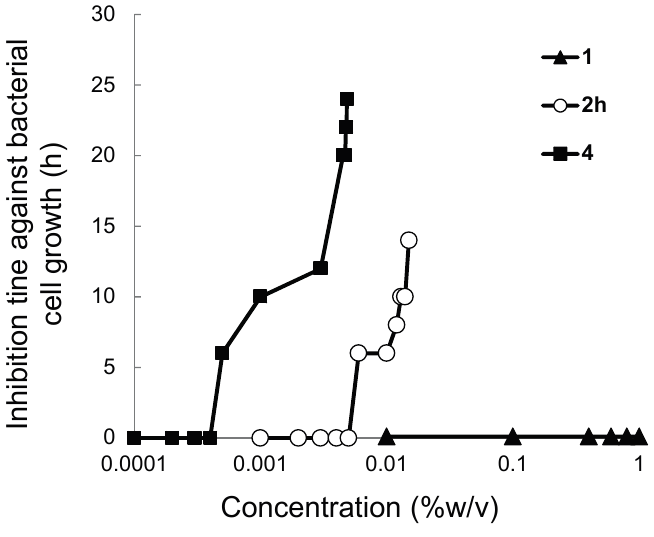
Figure 2. The inhibition time against growth of Bacillus subtilis subsp. subtilis (NBRC3134) as a function of the concentrations of DHS ( 1 ), C 14 ( 2h ) and PhSeSePh ( 4